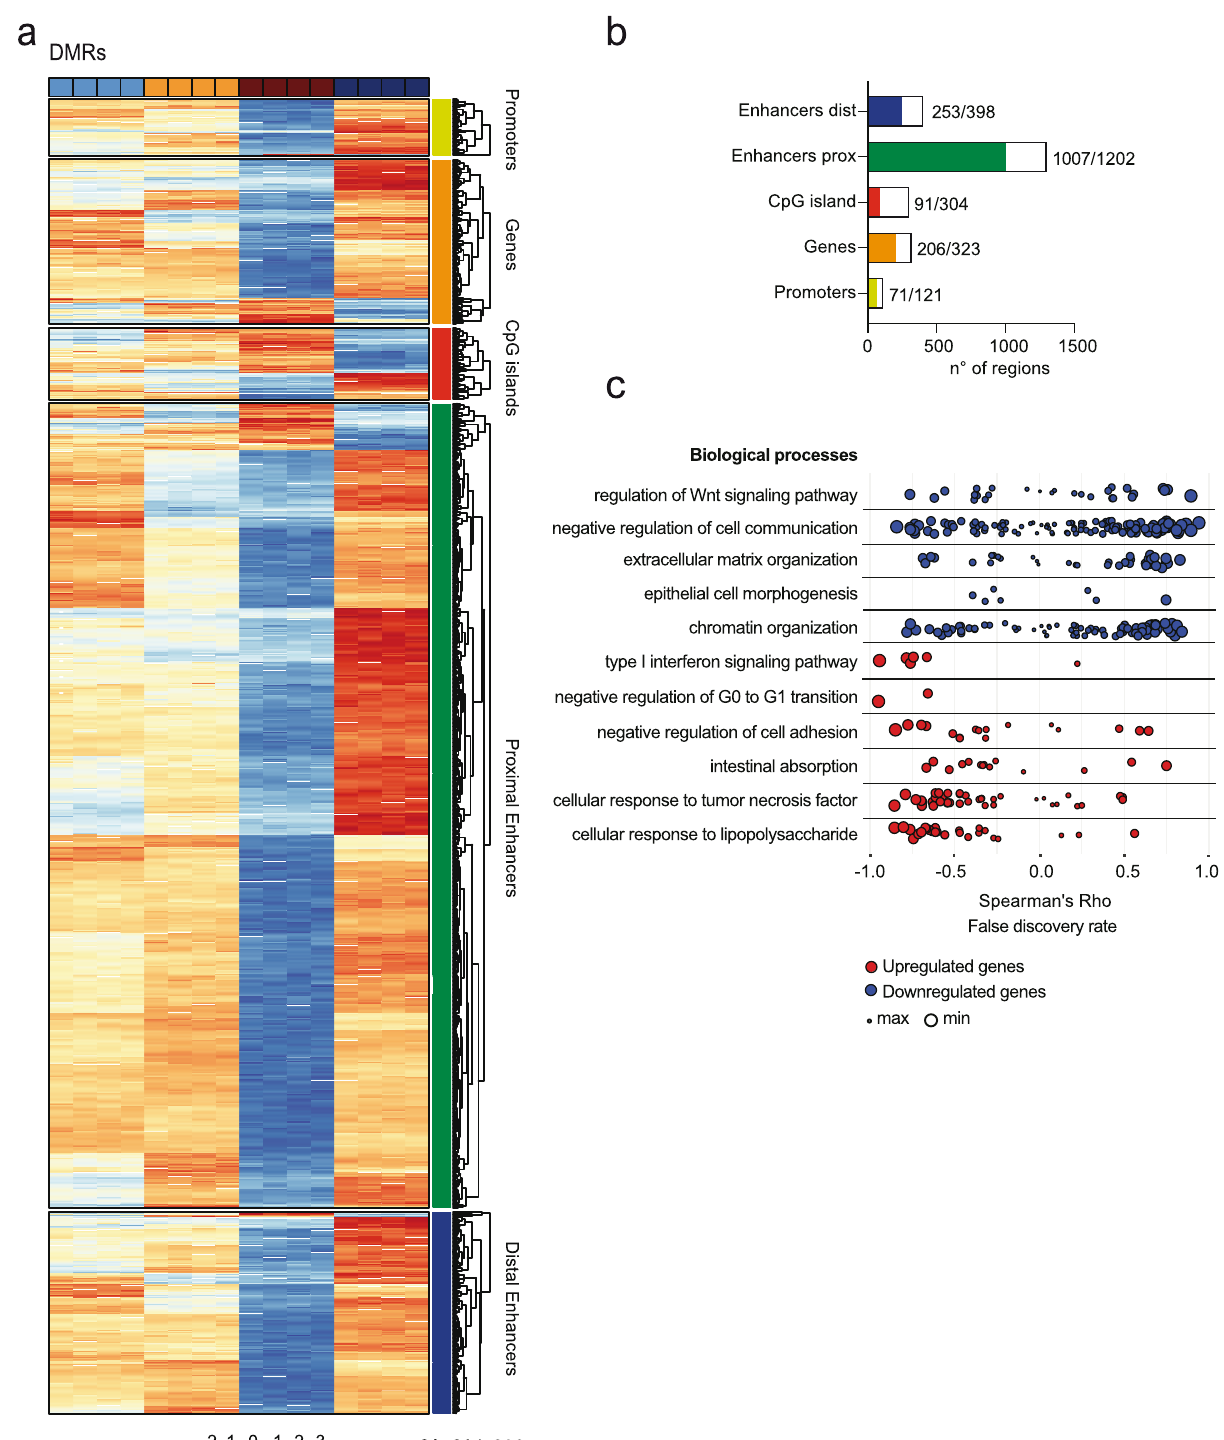
between gene expression and DNA methylation of up- (red) and downregulated (blue) rescued genes classi fi ed by the GO terms to which the genes belong. Top selectedGOterms enrichedin therescued genes are shown.Eachpoint represents a gene,and thesizeofthe points isproportionalto statisticalsigni fi cance (FDR)of the correlation with larger points being more signi fi